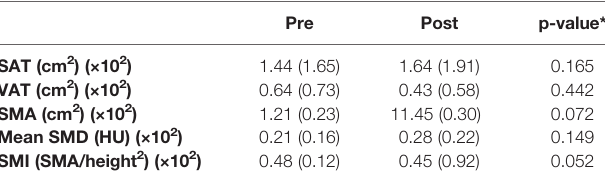
TABLE 3 | Body composition values before and after NACT (n =